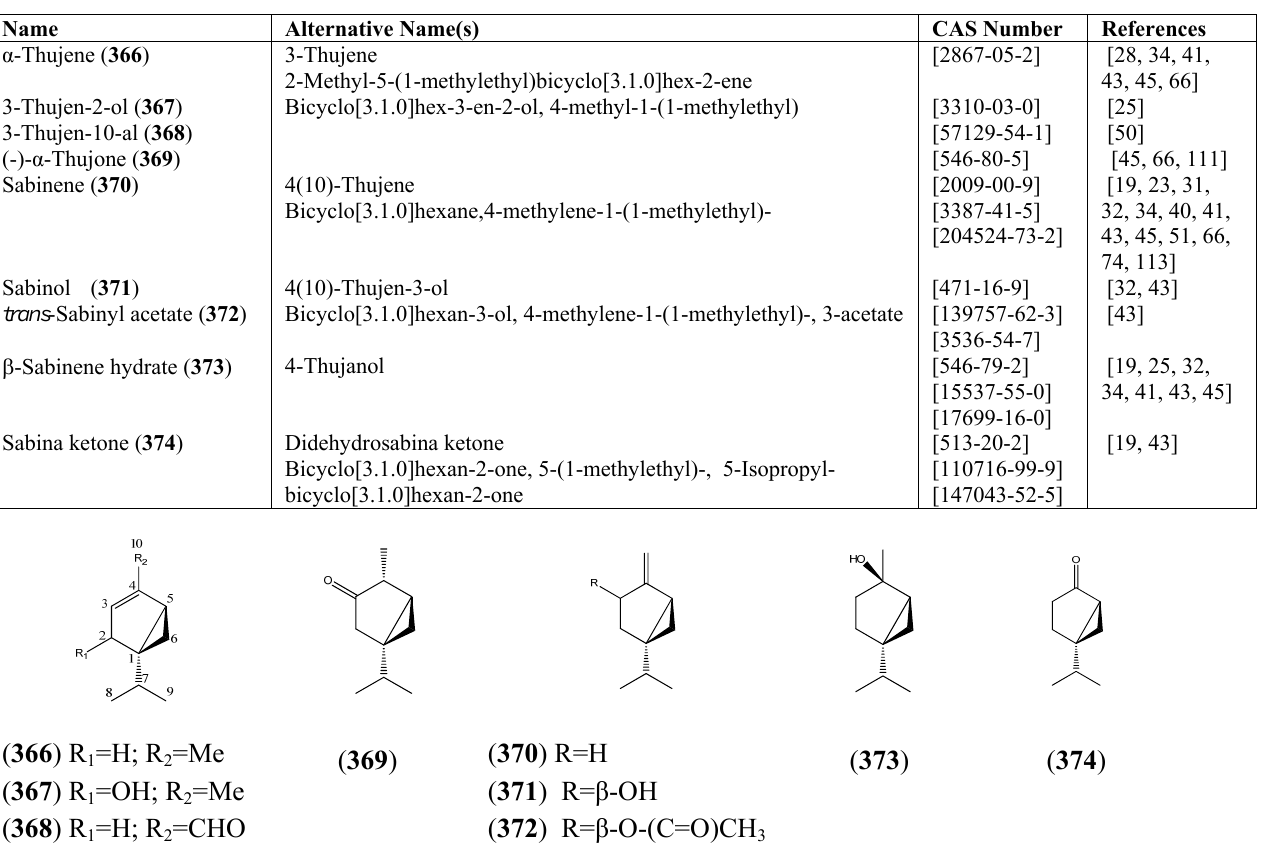
Table 28. Thujane Monoterpenoids (4-Methyl-1-(1-methylethyl)-bicyclo[3.1.0]hexane,